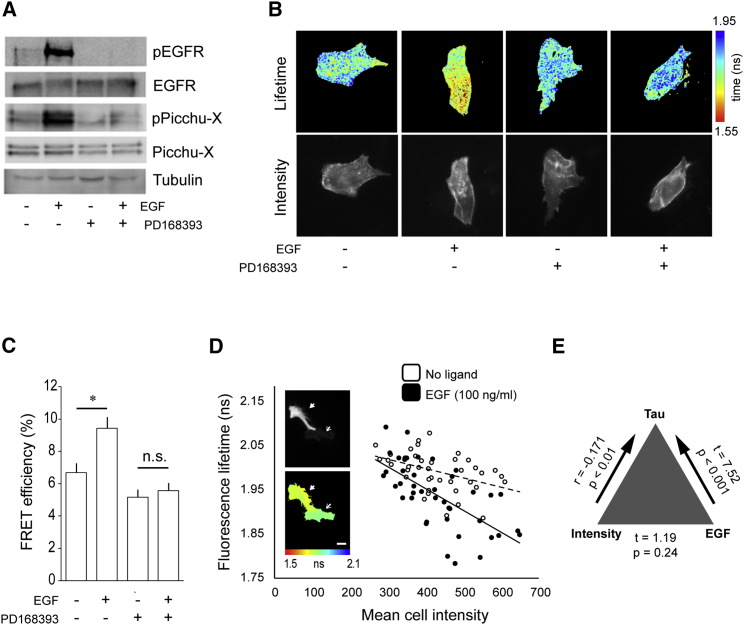
Biochemical Validation of the Picchu-X EGFR Activity Biosensor(A) Lysates of cells transiently expressing the Picchu-X biosensor were examined by western blotting with the indicated antibodies.(B) Donor fluorescence lifetime and intensity images for representative Picchu-X-expressing cells subjected to the indicated treatments. A PD16838-sensitive decrease in donor fluorescence lifetime is observed following treatment with EGF.(C) Quantification of average FRET efficiencies for treatment groups shown in (B). Data are mean FRET efficiencies, and error bars represent SEM. n ≥ 12 for each group; significance determined using Student’s t test (∗p < 0.05). n.s., not significant.(D) Population distribution of mean cell fluorescence lifetimes versus mean fluorescence intensities for Picchu-X-expressing cells treated as indicated. Donor fluorescence intensities (top) and associated lifetime maps (bottom) are indicated for two example cells with high (solid arrow) and low (empty arrow) levels of Picchu-X biosensor expression. Scale bar, 40 μm.(E) Three-way correlation analysis of biosensor donor lifetime, biosensor expression, and ligand treatment. Data related to lifetime, biosensor expression, and ligand treatment for all cells included in the siRNA library screen were included in the correlation analysis. Two-tailed Pearson correlation coefficient (r) reported a statistically significant association between intensity and τ (p < 0.01). The difference in τ between treatment groups (t = t-statistic value) was highly significant (p < 0.001) and incorporates the significant association between intensity and τ. There was no significant association between intensity and treatment (p = 0.24).